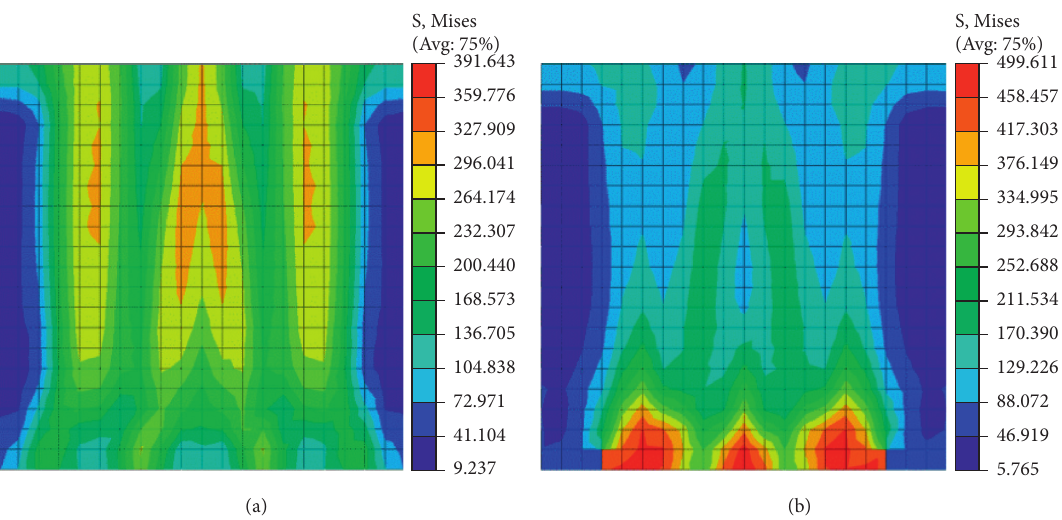
Figure 14: Von Mises stress distributions in the outer layer during the springback process: von Mises stress distribution during the unloading process at (a) h � 2.83 mm (b) and h �